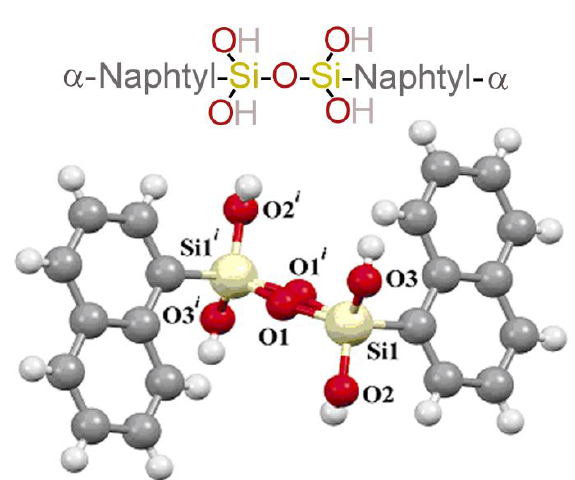
Figure 12. The molecular structure of 7 showing the atomic numbering of the non-carbon atoms (symmetry code ( i ) 1-x, 1-y, 1-z ). Atom O1 is disordered over two positions near the crystallographic center of symmetry at ( 1/2, 1/2, 1/2 ). Table 1. Crystal data for 7 .